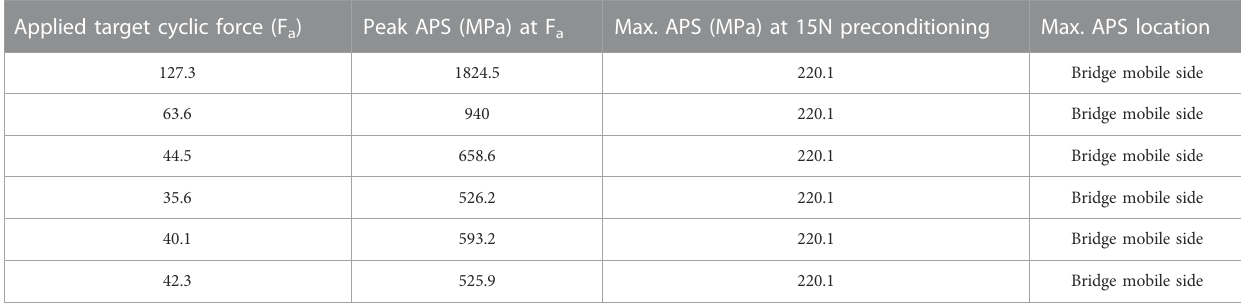
TABLE 3 Peak APS at applied and preconditioning load, and peak stress location in the fi nite element model. Applied target cyclic force (F a